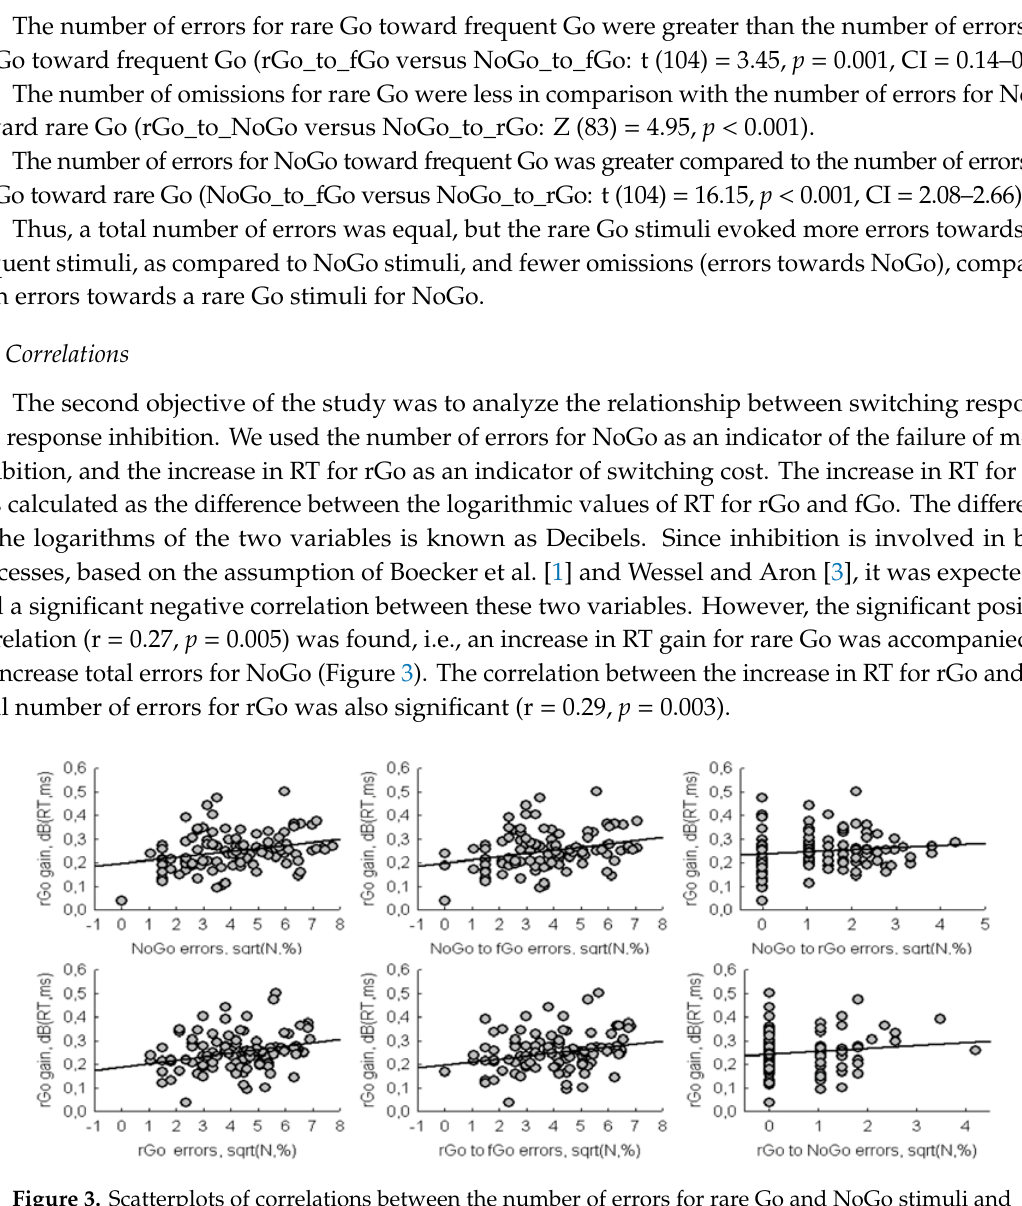
Figure 2. The error rates for total number and subcategories of errors for rare Go and NoGo stimuli.